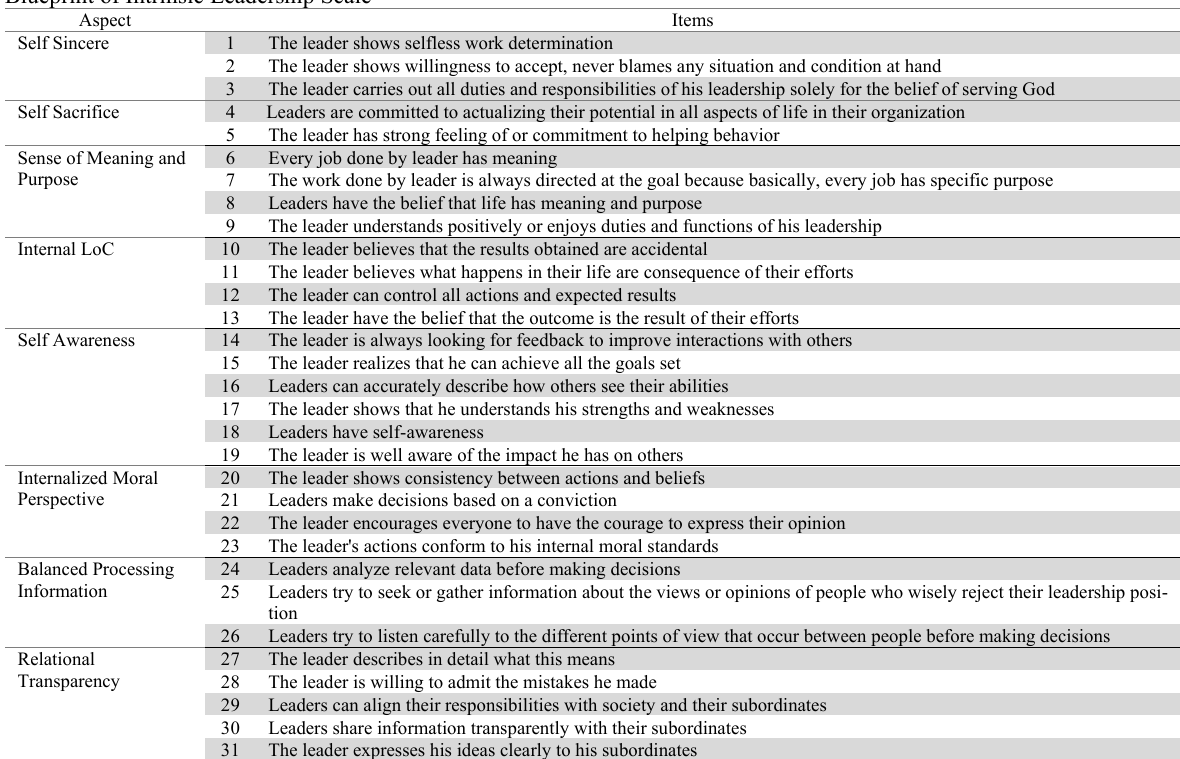
Blueprint of Intrinsic Leadership Scale